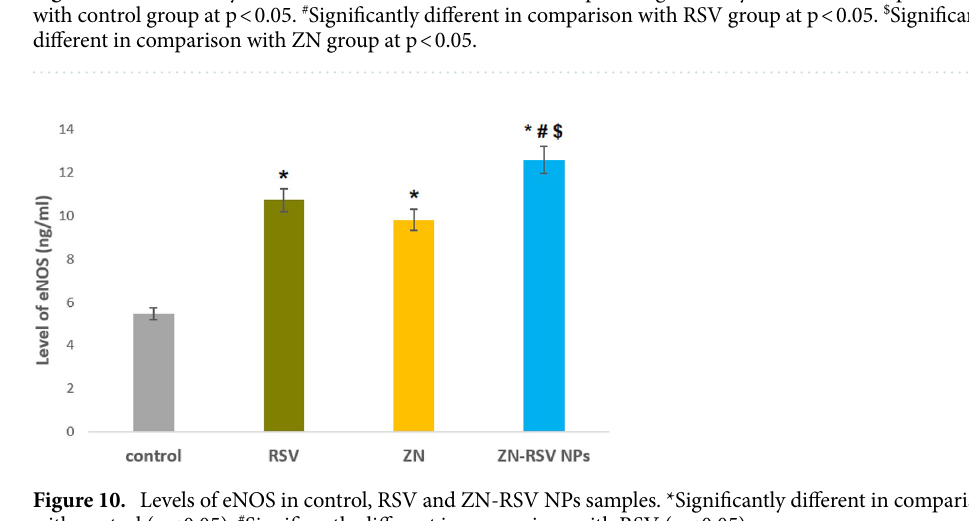
Figure 10. Levels of eNOS in control, RSV and ZN-RSV NPs samples. *Significantly different in comparison with control (p < 0.05). # Significantly different in comparison with RSV (p <